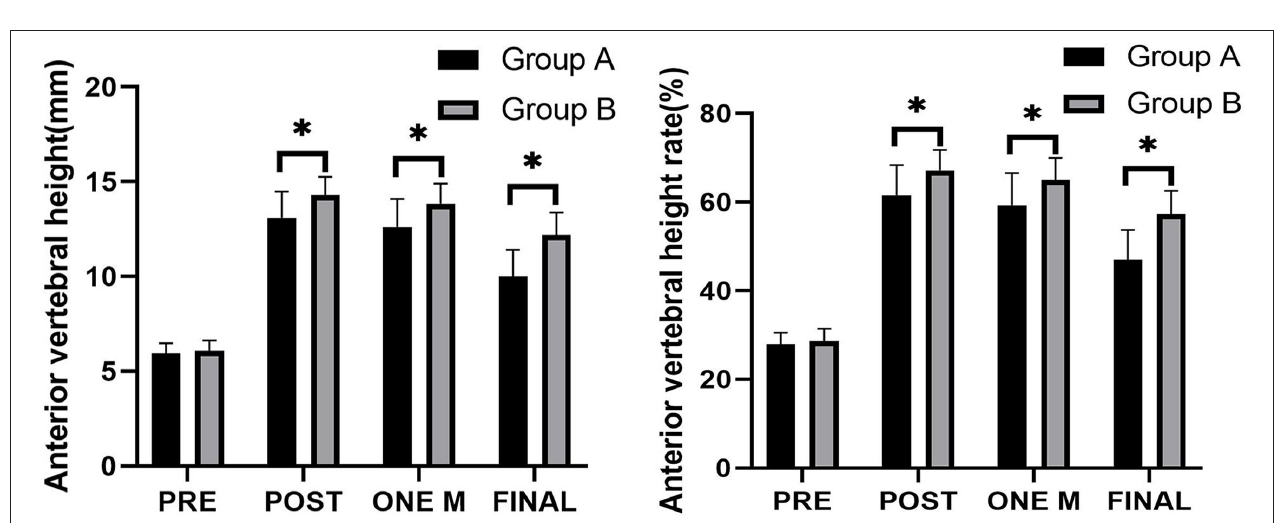
FIGURE 5 | Comparison of the anterior vertebral height (AVH) and anterior vertebral height rate (AVHr) between the two groups. * Significance between the two groups, P < 0.05.